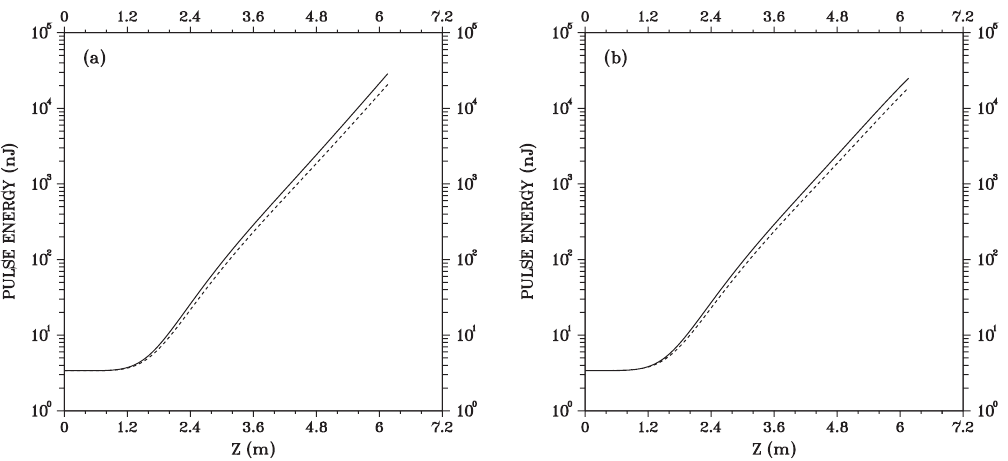
FIG. 1. FEL pulse energy (nJ) vs the undulator coordinate (meters): (a) continuous line from Eq. (2.12), dotted line from Eq. (2.11); (b) PROMETEO simulation: continuous line with short e-bunch, dotted line with continuous electron beam. Parameters: ¼ 2 : 8 (cid:2) 10 (cid:1) 2 m , (cid:6) ¼ 2 : 35 (cid:2) 10 (cid:1) 3 , (cid:8) ¼ 9 (cid:2) 10 (cid:1) 4 m , (cid:4) 0 ¼ 5 (cid:2) 10 (cid:1) 7 m , (cid:8) ¼ 4 : 5 (cid:2) 10 (cid:1) 4 m . (cid:4) u z